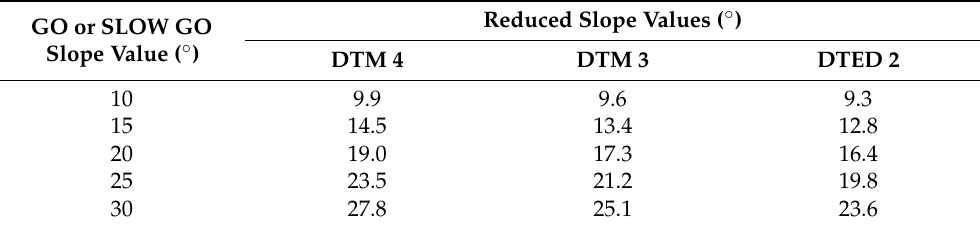
Table 5. Adjustments of maximum slope value reachable by a vehicle for passable (GO) and hardly passable terrain (SLOW GO) that were needed to achieve more accurate results for CCM